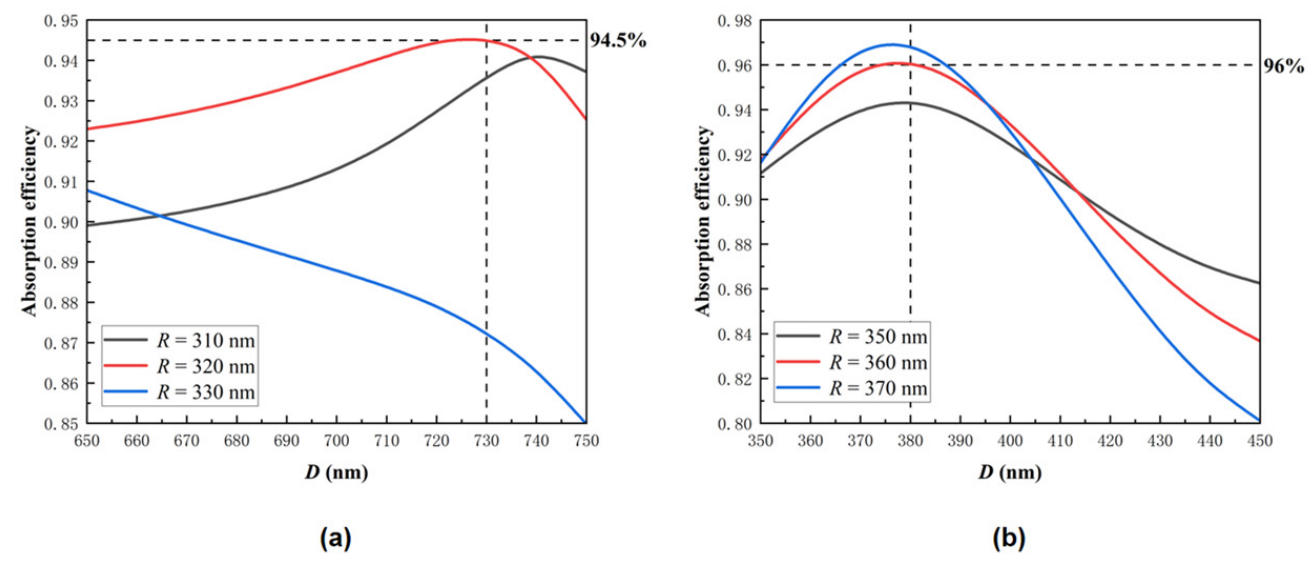
Figure 4. ( a ) The absorption efficiency of APD as a function of hole depth D = 650~750 nm when R = 310, 320, 330 nm; ( b ) the absorption efficiency of APD as a function of hole depth D = 350~450 nm when R = 350, 360, 370 nm.